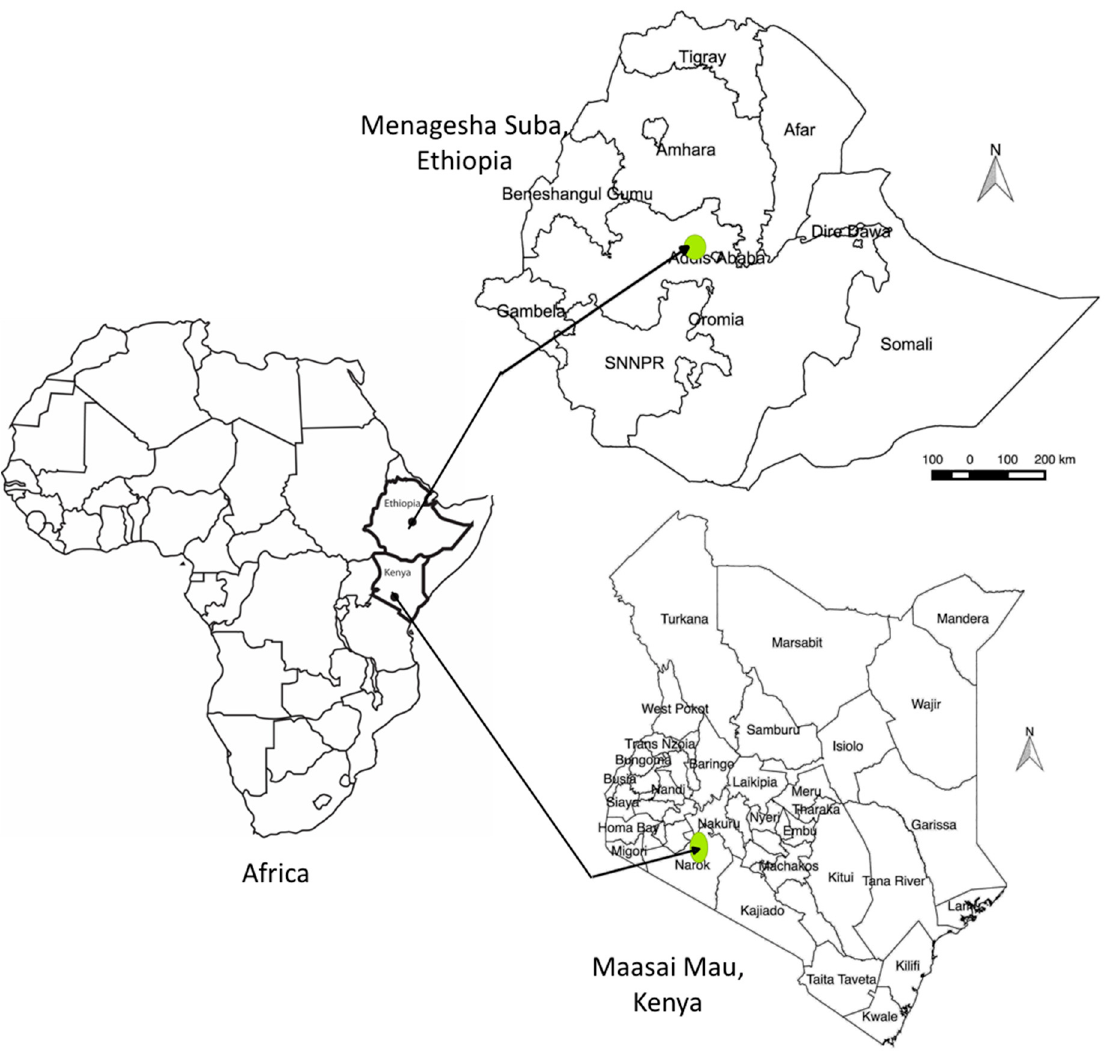
Figure 2. Location of the two case study forests, Menagasha Suba Forest, Ethiopia, and Masaai Mau forest, Kenya.